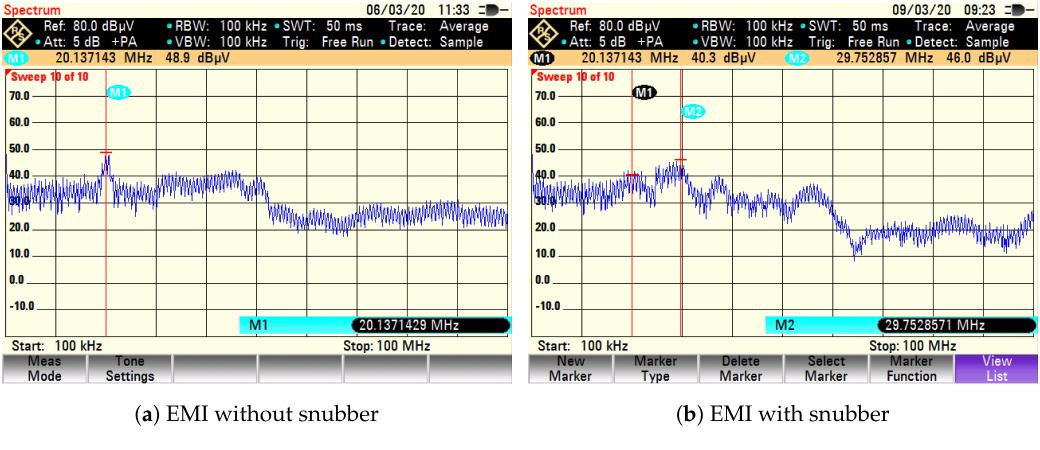
Figure 17. EMI for the SEPIC converter “ V in = 24